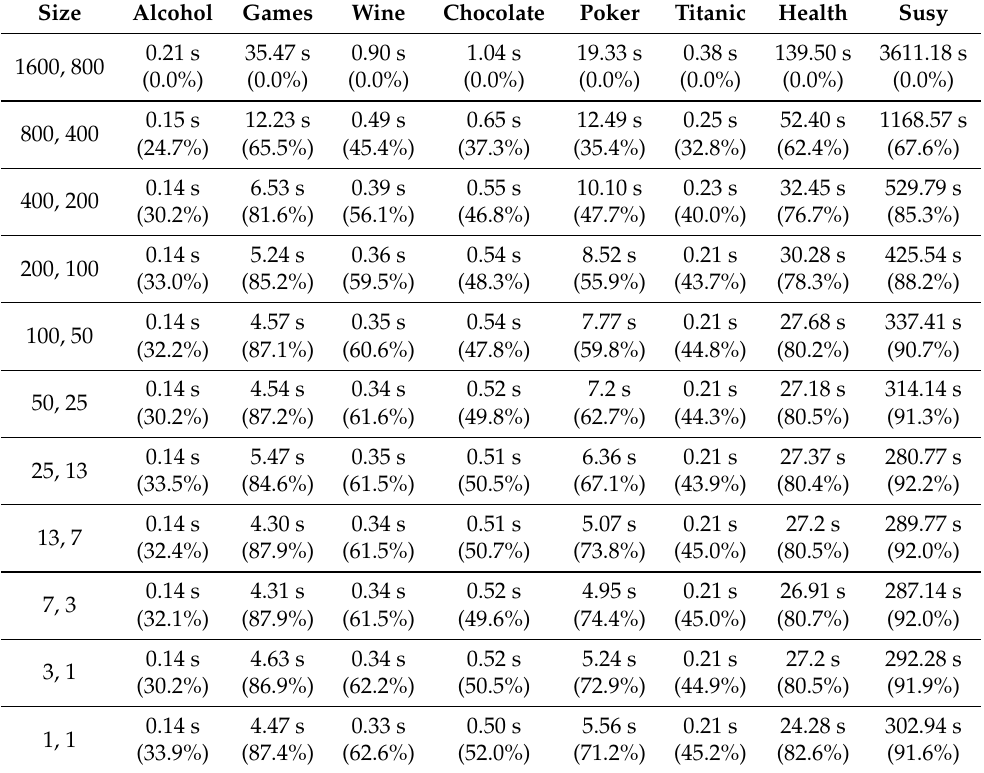
Table 2. Train times averaged over all epochs. The size column shows the prune states representing the number of nodes in each layer of the neural network, each state 50% smaller than the last. Then for each dataset we provide the average epoch train time in seconds followed by the percentage improvement from [1600, 800] in